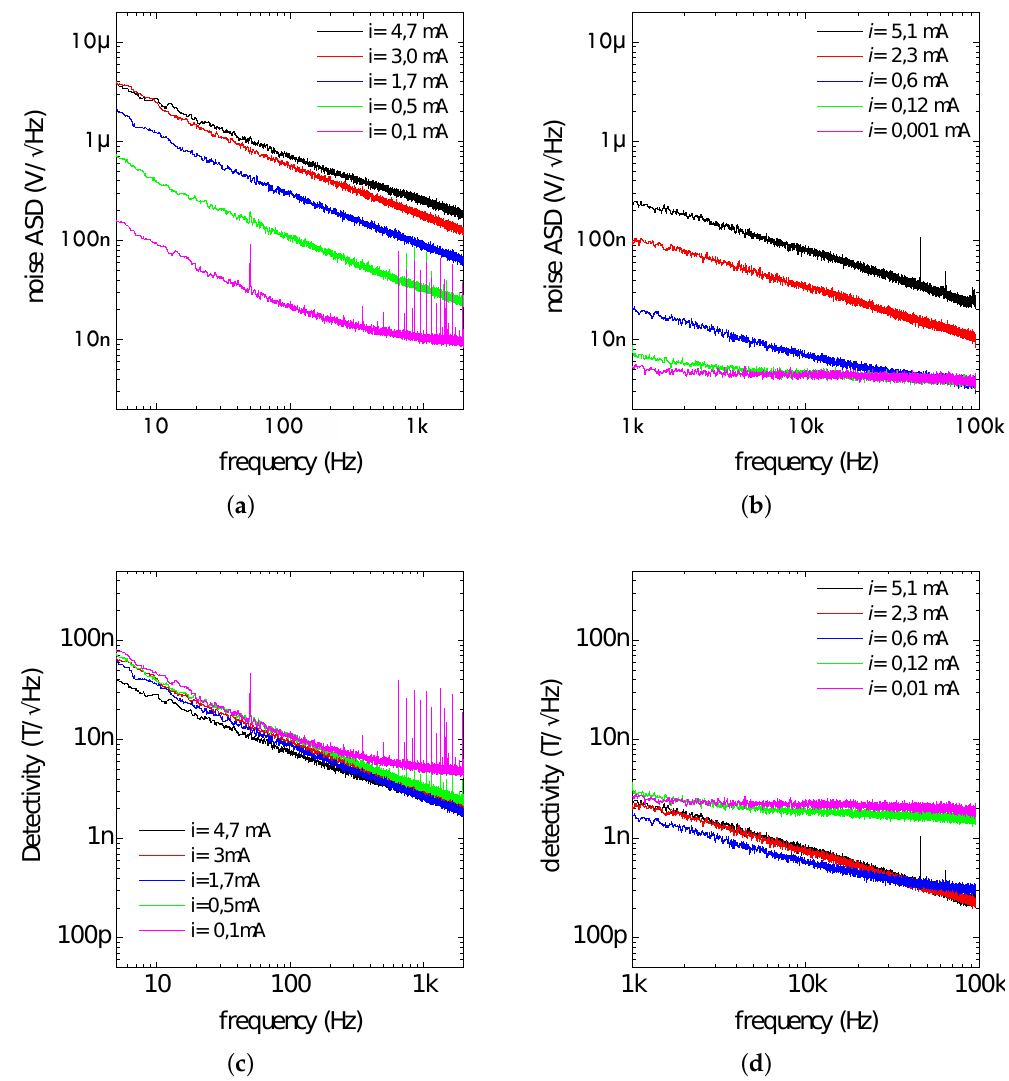
Figure 2. Noise measurement data on 3 200 µ m 2 spin valves as described in [11]: ( a ) low frequency noise; ( b ) high frequency noise; ( c ) low frequency detectivity; ( d ) high frequency detectivity.